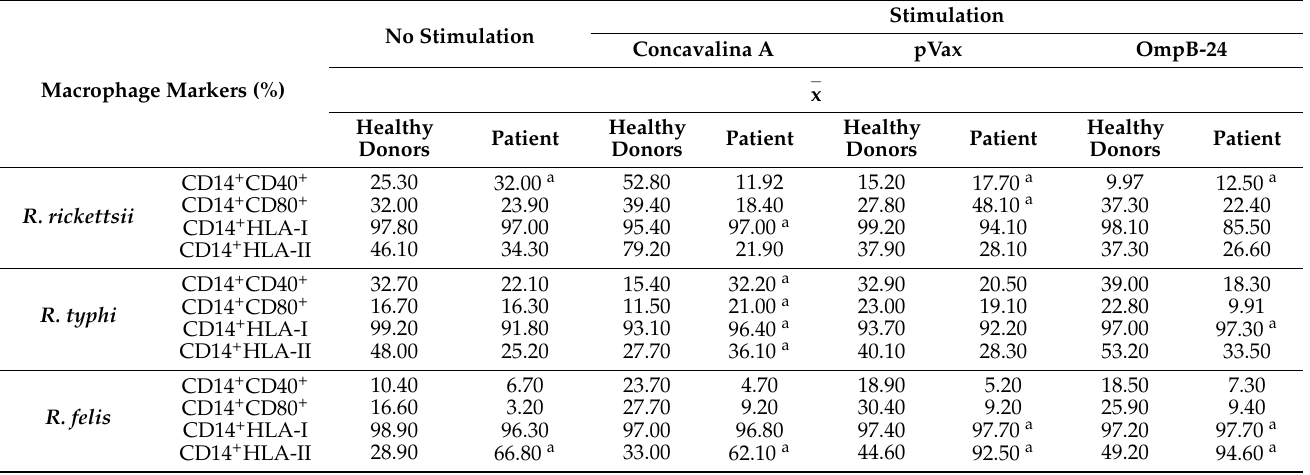
Table 2. Percentage of macrophages (CD14+) expressing CD40+, CD80+, HLA-I and HLA-II. to the statistical mean.